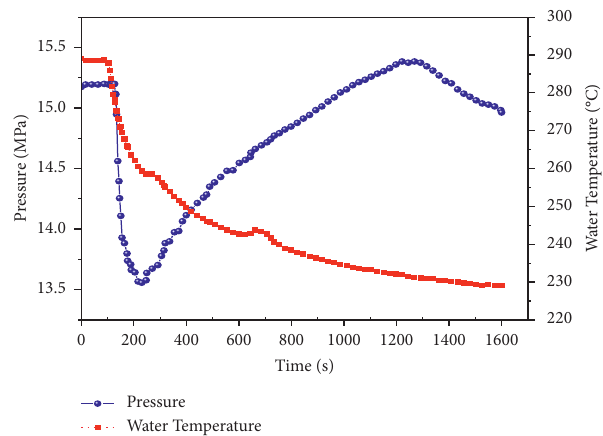
Figure 3: AOO transient reference data for temperature and pressure